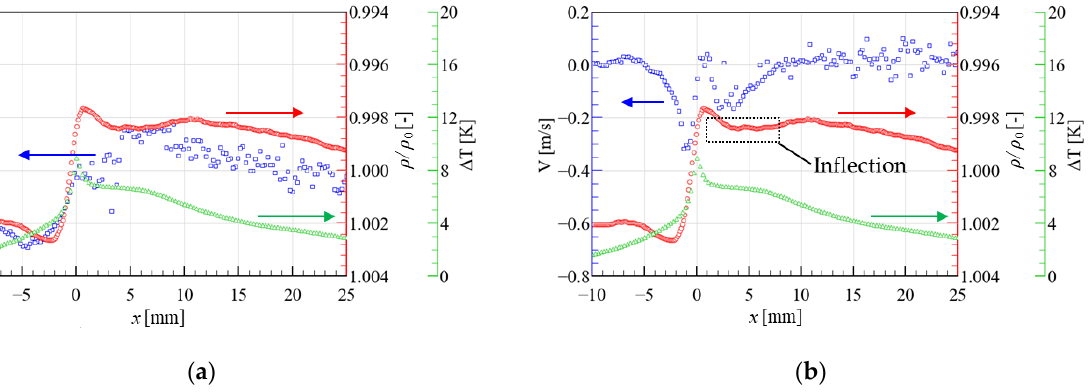
Figure 16. x -profiles of the flow, density field, and surface temperature of the wire-PA: ( a ) x -profiles of the horizontal velocity, density, and temperature; ( b ) x -profiles of the vertical velocity, density, and temperature. The blue marker shows the horizontal and vertical velocities. The red and green markers respectively show the density and surface temperature.